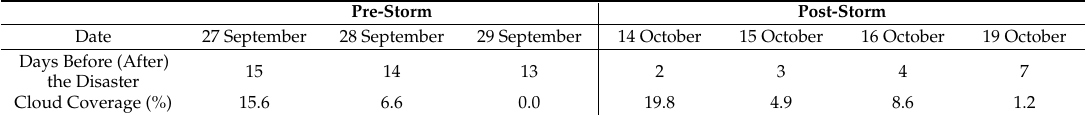
Table 8. The dates and cloud coverages of pre- and post-storm DNB images of the Cyclone Hudhud.